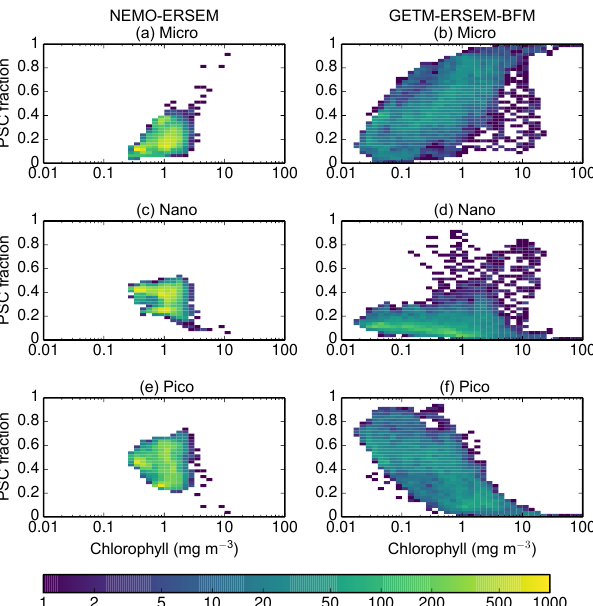
Figure 12. 2-D histograms of the distribution of each phytoplankton size class (PSC) with chlorophyll, from NEMO-ERSEM (a, c, e) and GETM-ERSEM-BFM (b, d, f) . The PSC fractions have been calculated at each surface model grid point in the monthly means for August 2010 and August 2011. Colours represent the number of occurrences per